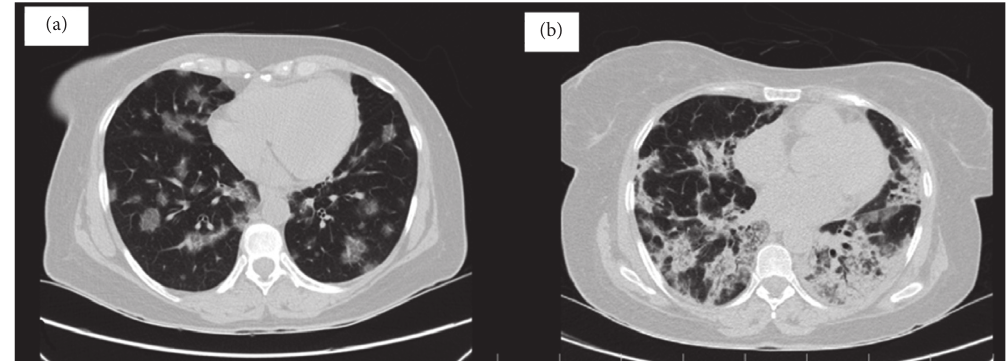
Figure 3: Spiral chest CTscans imaging: (a) diagnostic chest CTscan showing bilateral multifocal, dominantly peripheral, patchy ground- glass opacities suggestive of COVID-19 pneumonia. (b) Follow-up chest CT scan after 18days showing notable progression in bilateral alveolar opacities with coarse reticular pattern (pulmonary fibrosis) in comparison with previous CT.